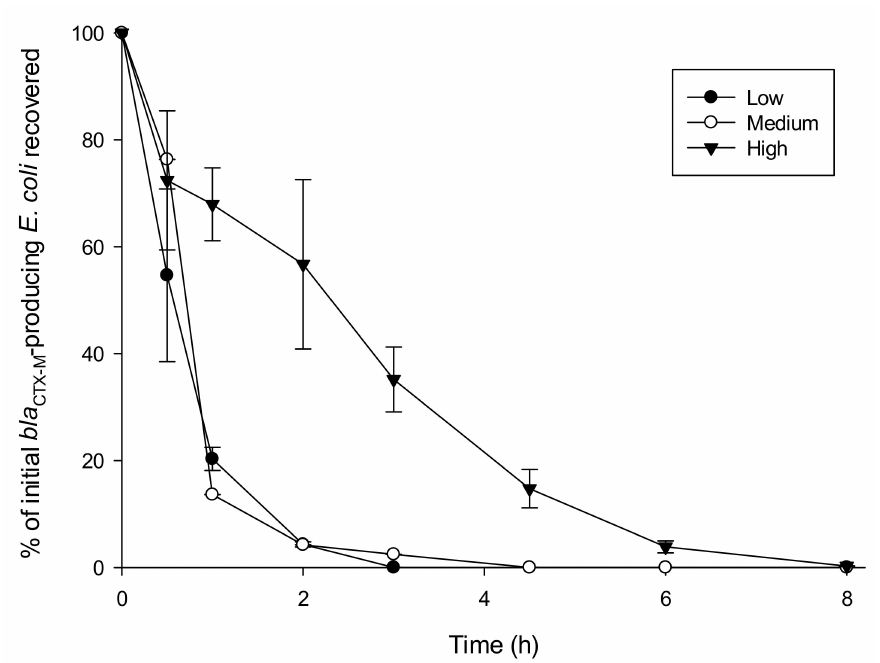
Figure 1. Percentage of initial ( t 0 ) bla CTX-M-15 -producing E. coli recovered in the freshwater of di ff erent turbidity levels (low, medium or high) over time, following exposure to UV irradiation. Based at the irradiance level of 40 W / m 2 , the equivalent UV dose exposure in winter would be after 14 min, and in summer would be after 4.5